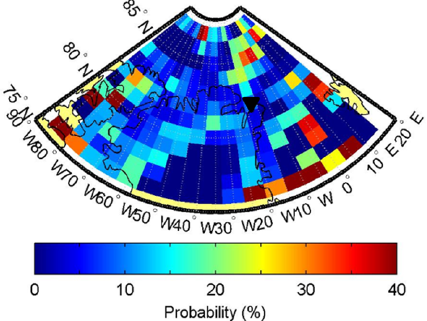
Figure 8. The probability of observing an event at Station Nord (bottom tip of the black triangle) as a function of air mass origin. This figure uses all available data (62 events) from the study period July 2010–February 2013.